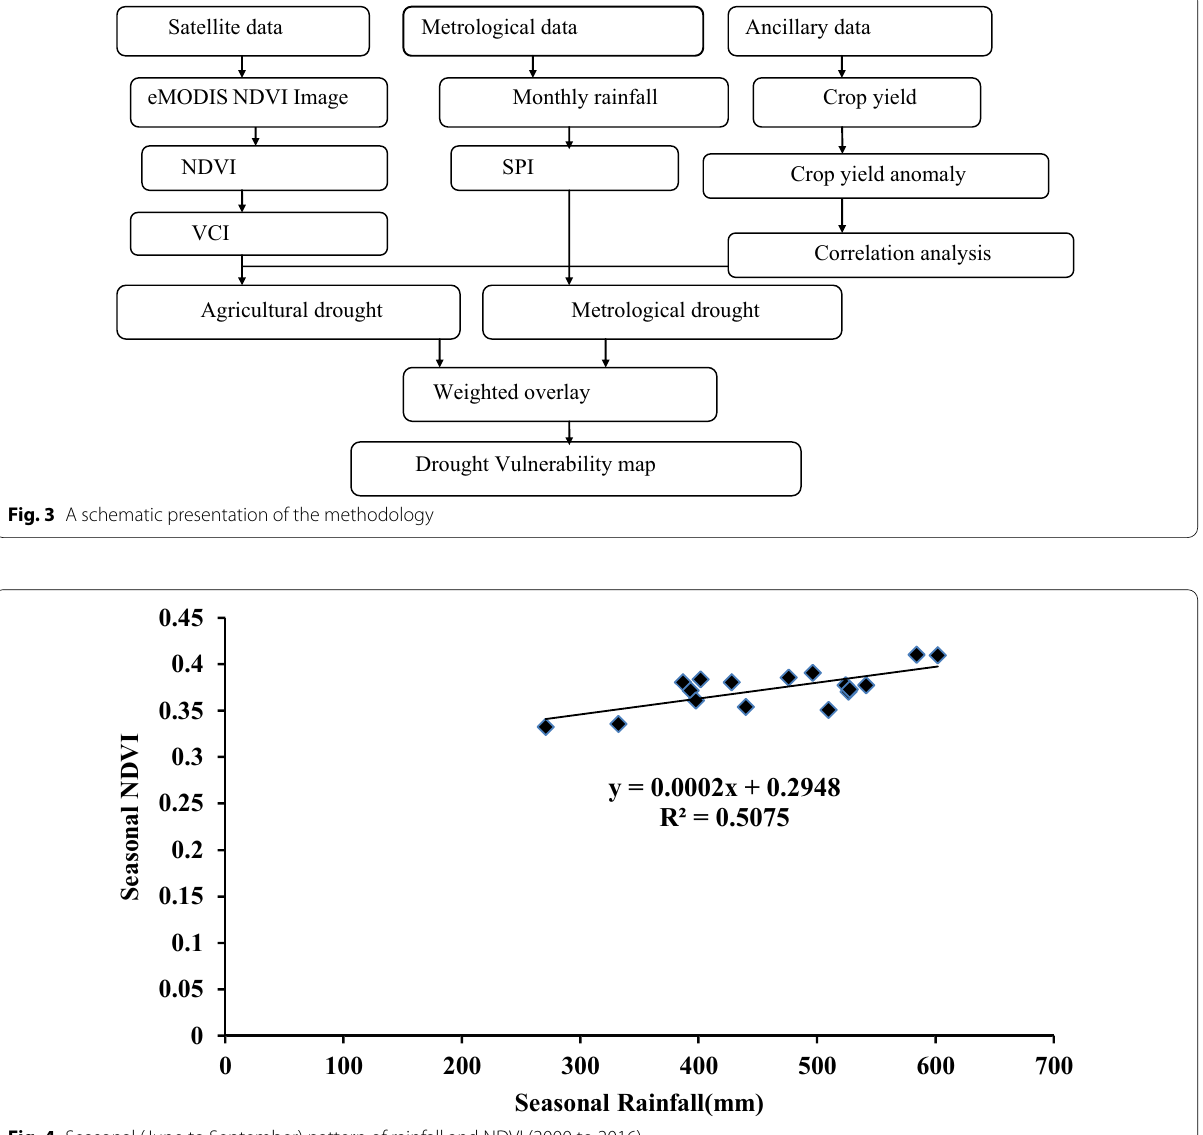
Fig. 4 Seasonal (June to September) pattern of rainfall and NDVI (2000 to